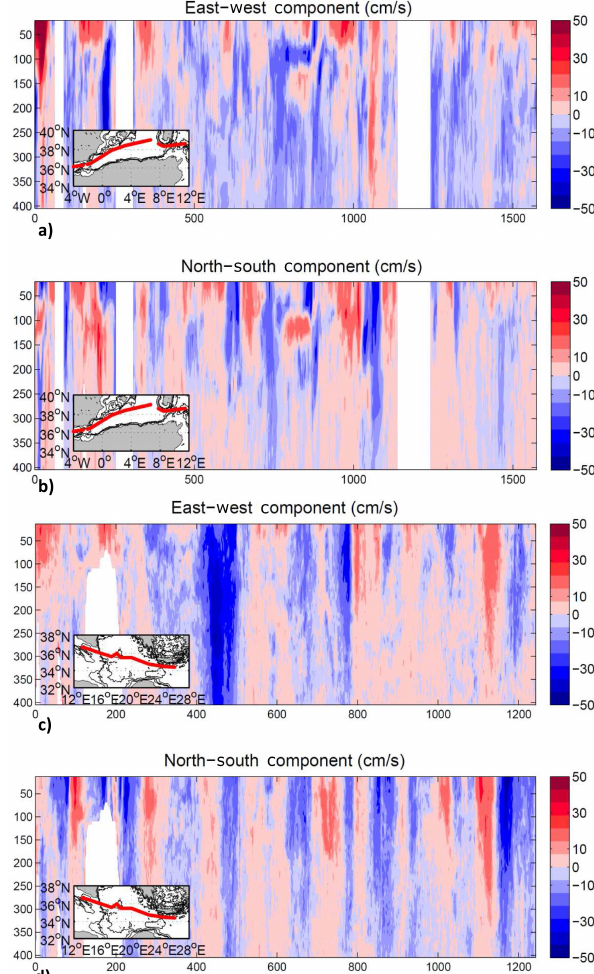
Figure 4. Velocity distribution of the upper 400m of the water column along a west–east section through (a) the western Mediter- ranean Sea and (b) the eastern Mediterranean Sea. Data are recorded by a shipborne ADCP. Shown are the east–west and north–south ve- locity component, respectively. Inner panels indicate the location of the ship track. White areas: no data are available. x axes: east–west distance (km). y axes: depth